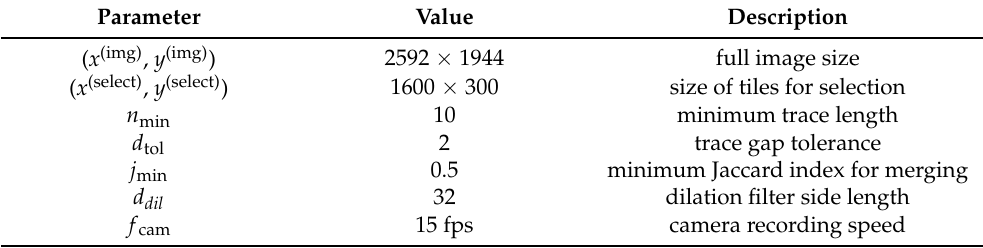
Table 1. Parameters and the assigned values for evaluating the presented focus determination